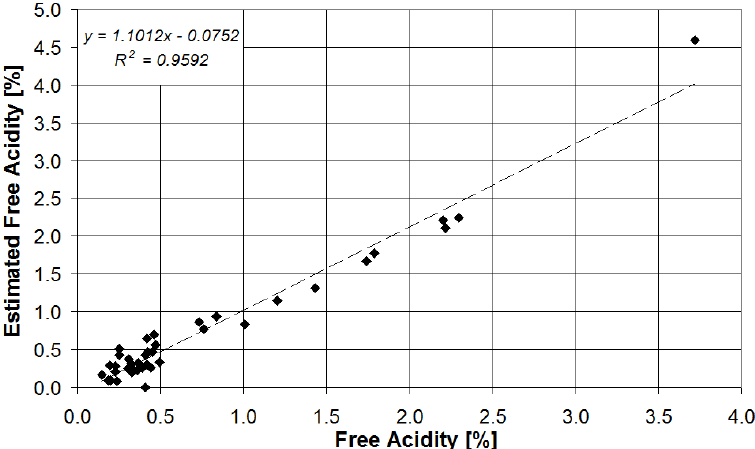
Figure 14. Estimated value of free acidity using the compensation algorithm of Equation (13) and the polynomial function of order 3 plotted vs. the free acidity determined with the reference pro- cedure.